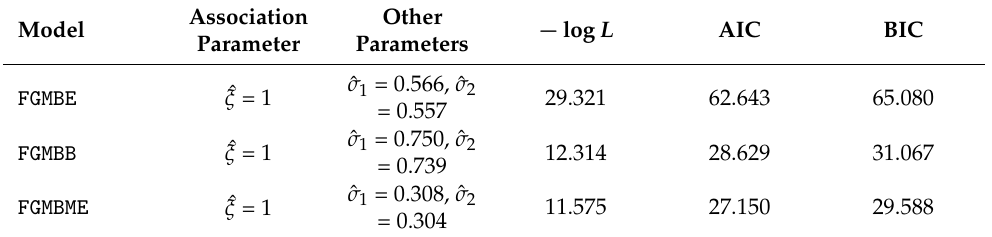
Table 1. ML estimates, log L , AIC and BIC values of the considered models. −